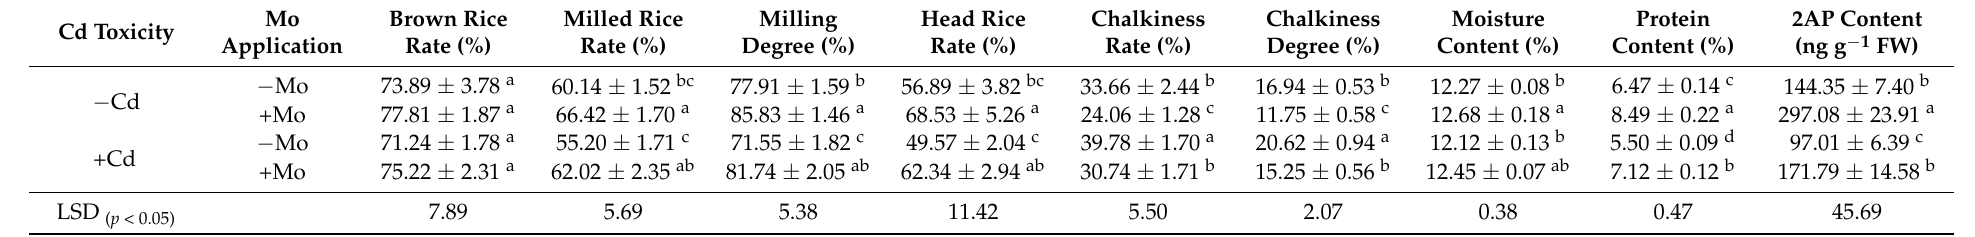
Table 2. Influence of Mo supply and Cd toxicity on aromatic rice grain quality